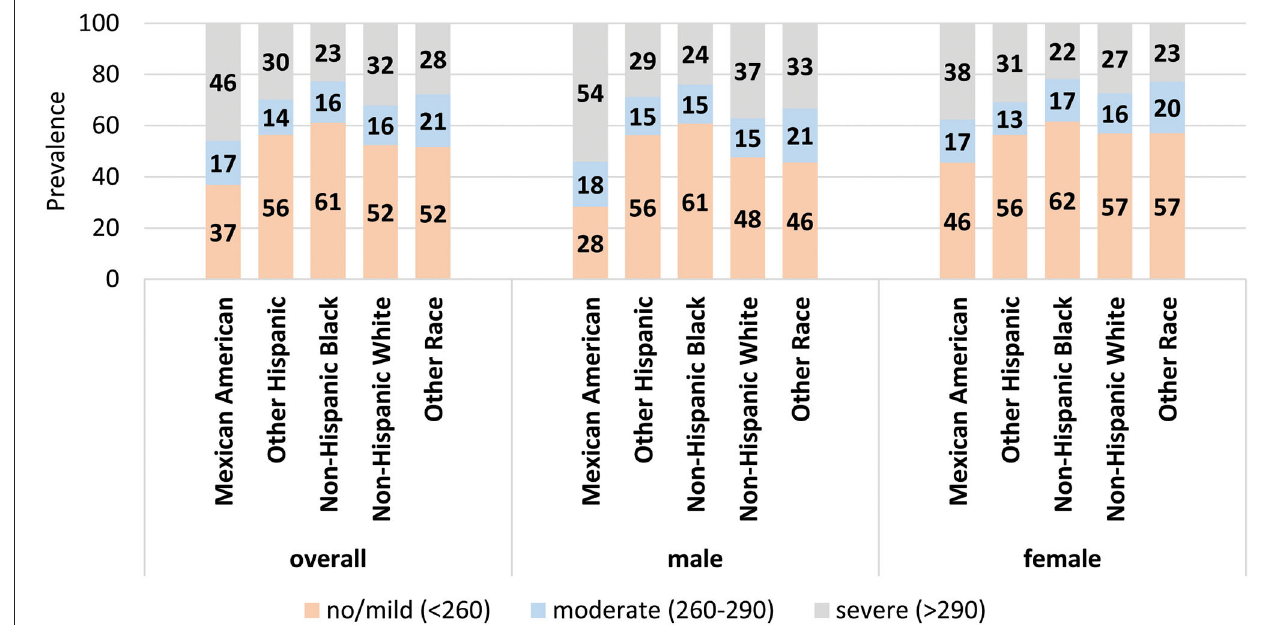
FIGURE 1 | Prevalence of stages of NAFLD by race/ethnicity. The prevalence of each stage of NAFLD within each racial/ethnic group for the population overall (left) and for males and females separately (middle and right). Data labels denote the prevalence of each